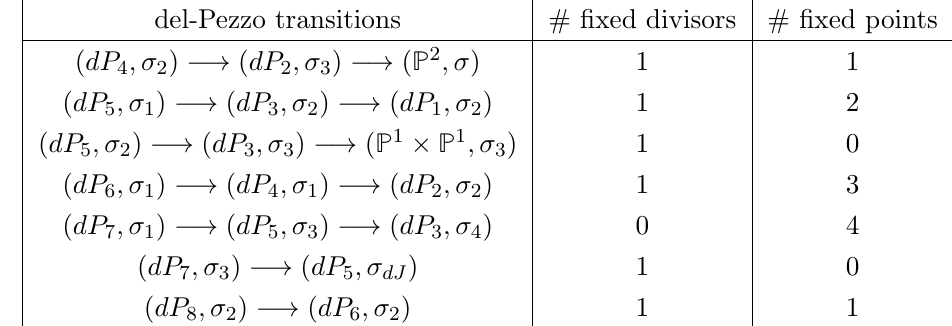
and h 1 ; 1 decrease by + (cid:0) by (cid:6)